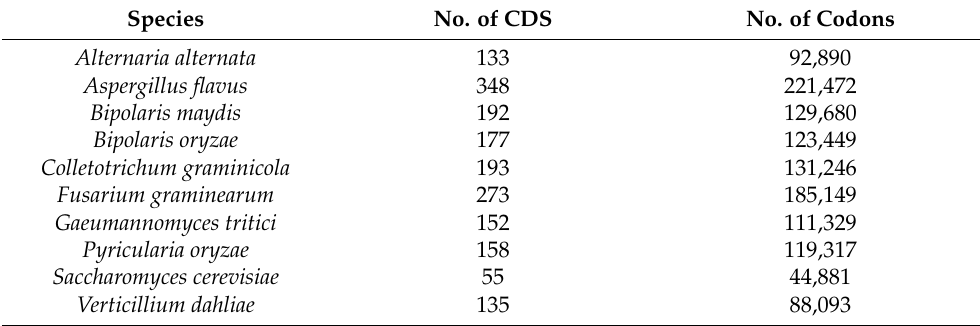
Table 1. The number of Zn(II) 2 Cys 6 coding sequences and codons considered for codon usage bias in Ascomycetes fungi and model S. cerevisiae